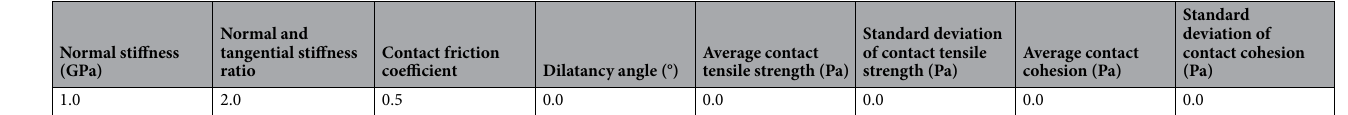
Table 3. Meso-parameters of the smooth-joint model in the numerical simulations.